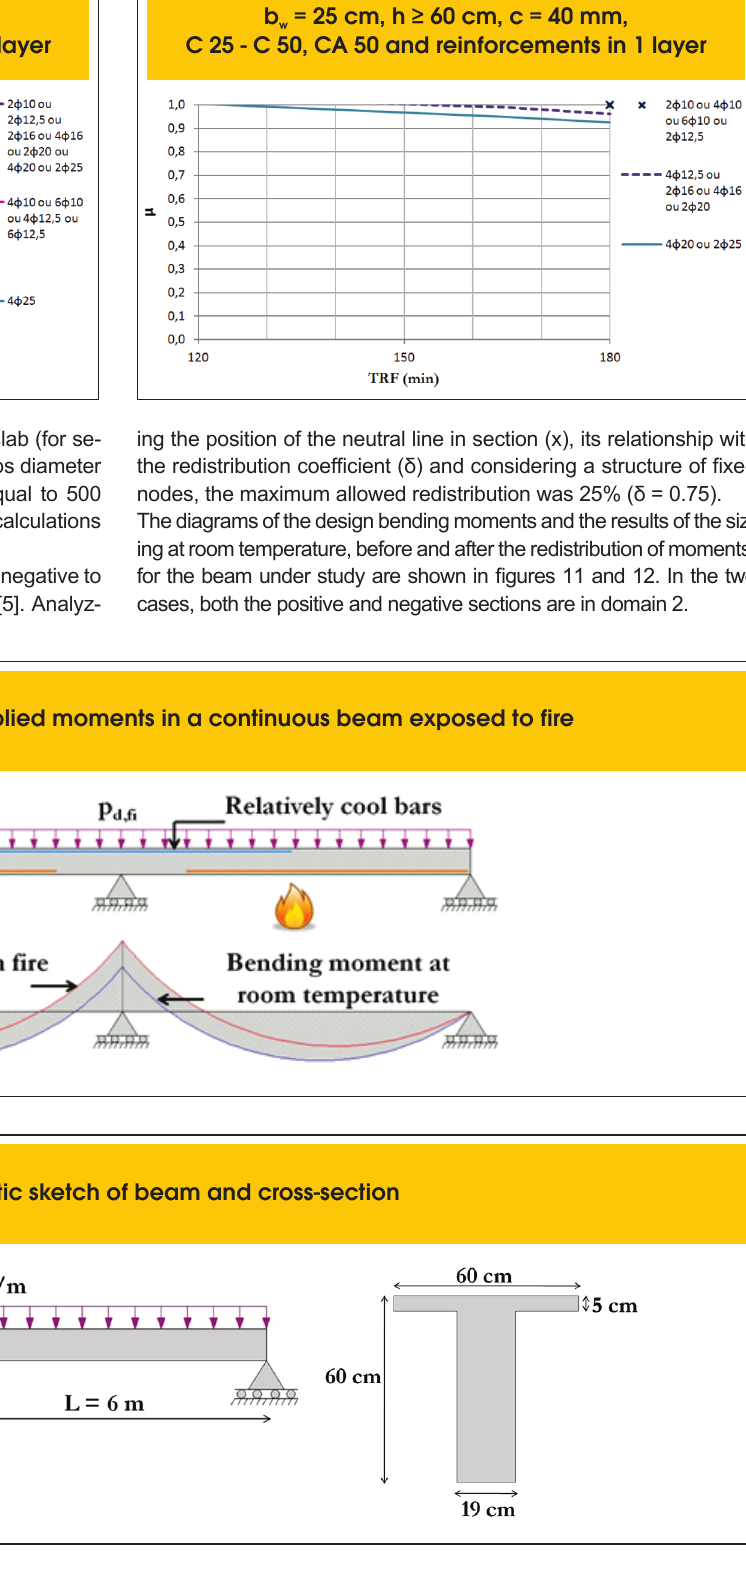
Figure 8r – TRF x m for beam with negative moment, b = 25 cm, h ≥ 60 cm, c = 40 mm, w C 25 - C 50, CA 50 and reinforcements in 1 layer